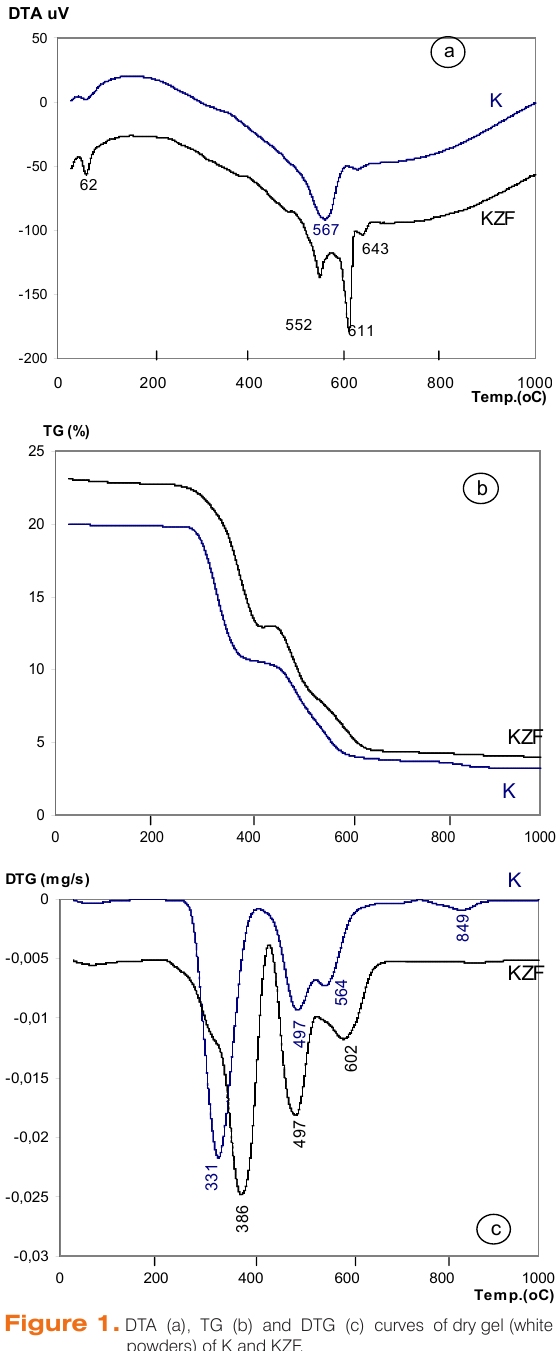
Figure 1. DTA (a), TG (b) and DTG (c) curves of dry gel (white powders) of K and